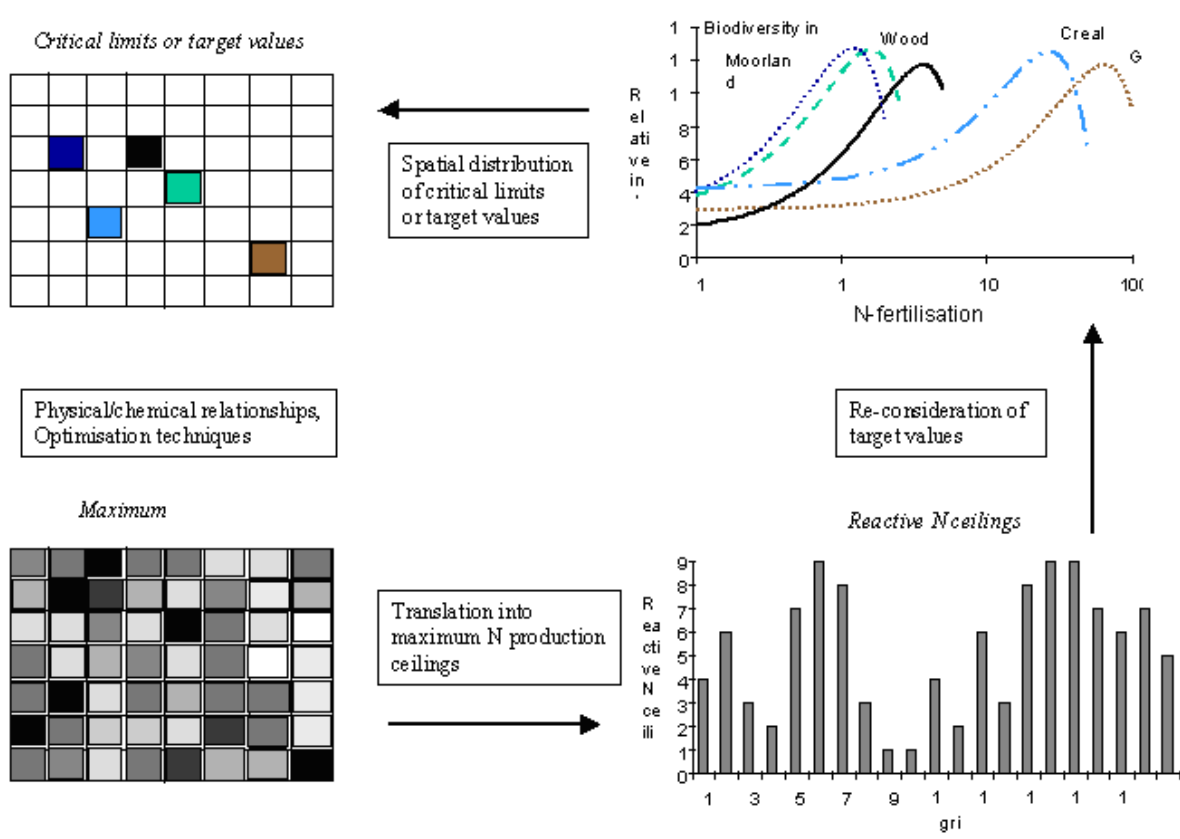
FIGURE 2. Illustration of the calculation of reactive N ceilings on a regional